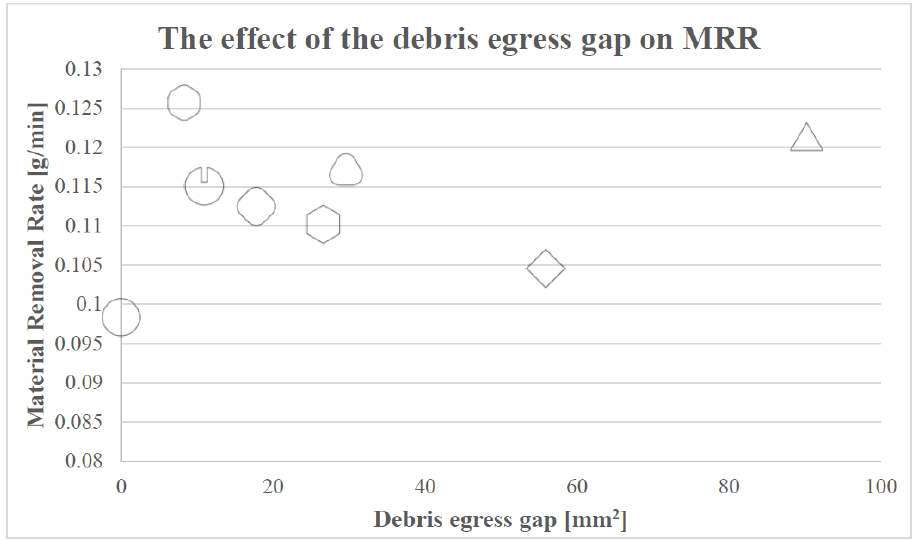
Figure 13. The relationship between the MRR and the debris egress gap.